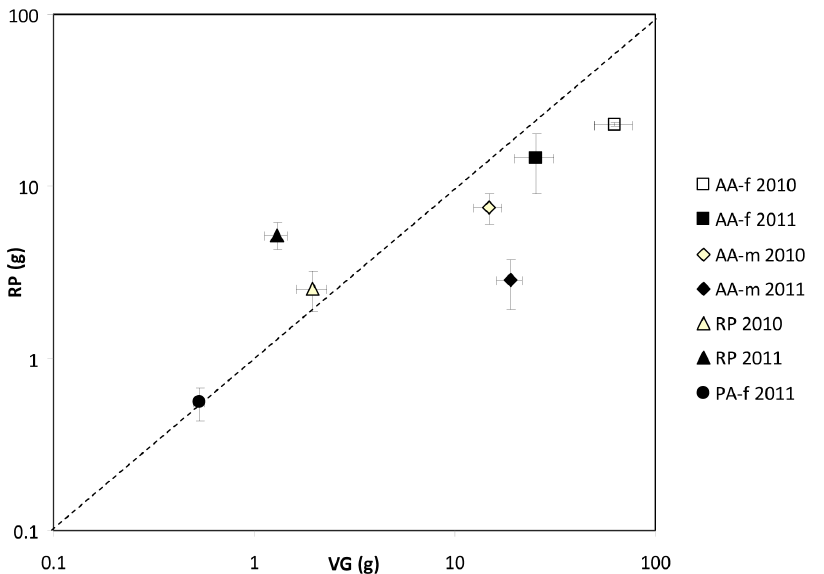
Figure 3. Relationship between vegetative and reproductive production. Relationship between mean ( 6 SE) vegetative mass (VG=leaf + stem mass) and the mean ( 6 SE) reproductive mass (RP=inflorescence + infrutescence mass) produced per previous-year stem in each species (AA- Ailanthus altissima , RP- Robinia pseudoacacia , PA- Populus alba ), each sex (f-female, m-male) and each study year (2010 and 2011). The dashed line indicates the 1:1 relation between VG and RP. Species lying above this line invested more in reproduction, while species below the line invested more in vegetative growth. (Note the log-scale of both axes). doi:10.1371/journal.pone.0100254.g003 (Fig. S2). Among all analyses, DBH was only significant in the case of S t /S t 2 1 of 2011, where it showed a negative slope (i.e. thicker trees tended to produce less stem mass). In 2011, the random factor (tree) explained between 37 and 57% of the variance not from 6% to 83% (Table 3).